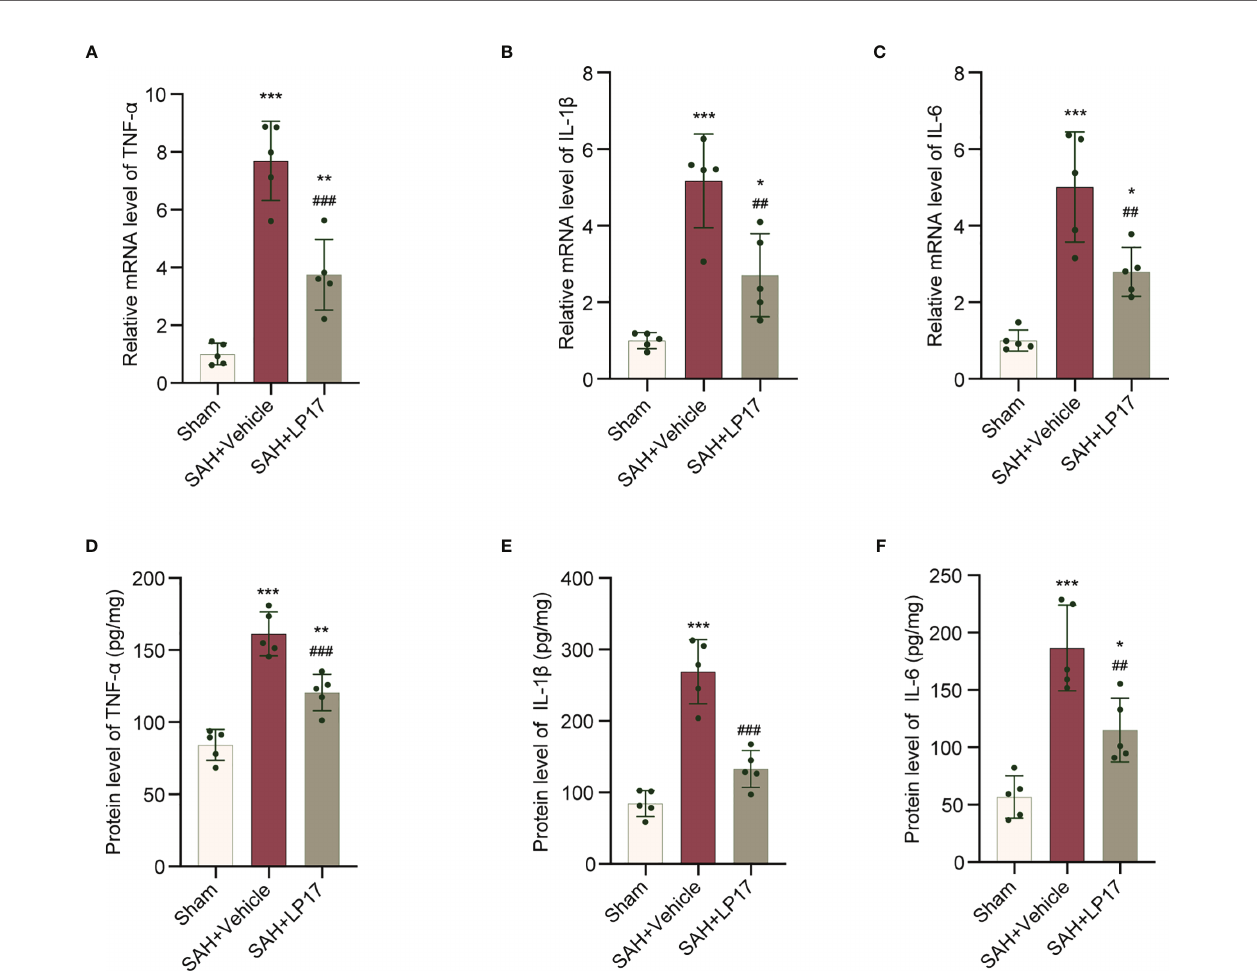
FIGURE 6 | LP17 treatment inhibited neuroin fl ammation. (A – C) Relative mRNA levels of in fl ammatory marker genes (TNF- a , IL-1 b , IL-6). n = 5/group. (D – F) Quantitative analysis of ELISA levels of in fl ammatory markers (TNF- a , IL-1 b , IL-6). n = 5/group. Data are expressed as mean ± SD. *P < 0.05, **P < 0.01, ***P < 0.001 vs Sham group; ## P < 0.01, ### P < 0.001 vs SAH+vehicle